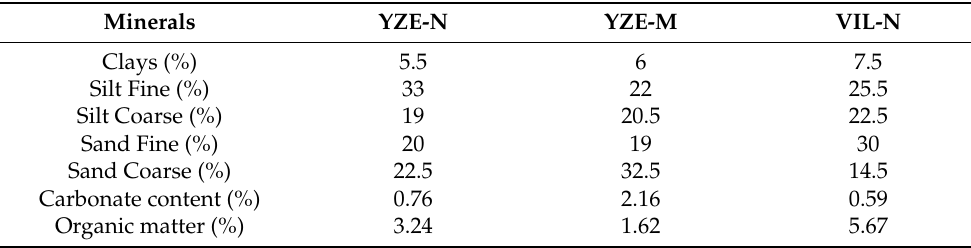
Table 8. Mineral composition of each